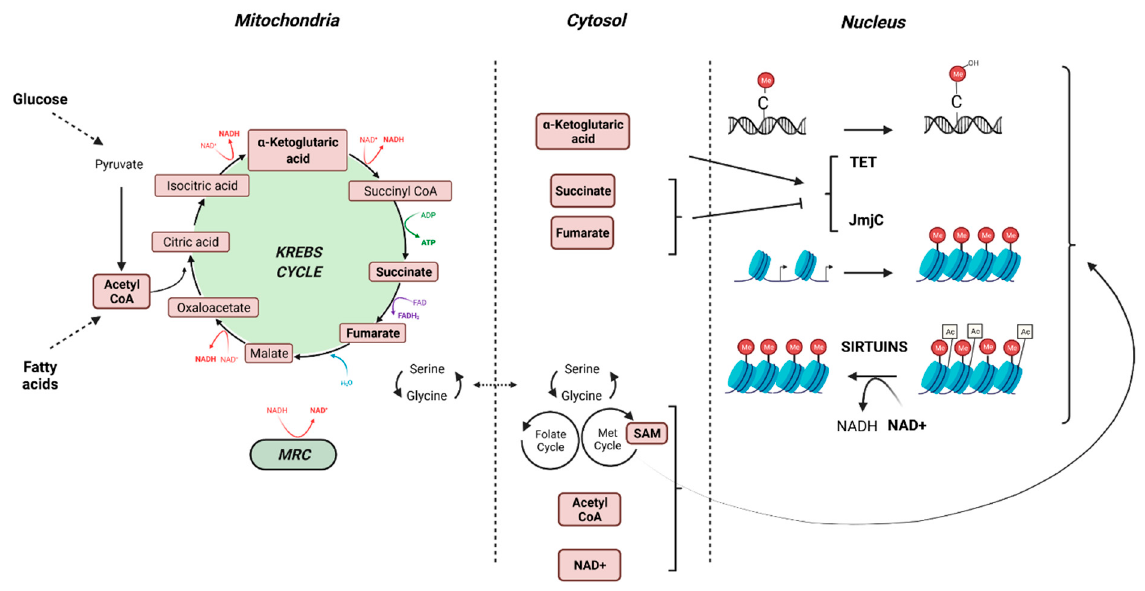
Figure 2. Crosstalk between the mitochondria and the epigenome (created with BioRender.com, accessed on 30 November 2021).